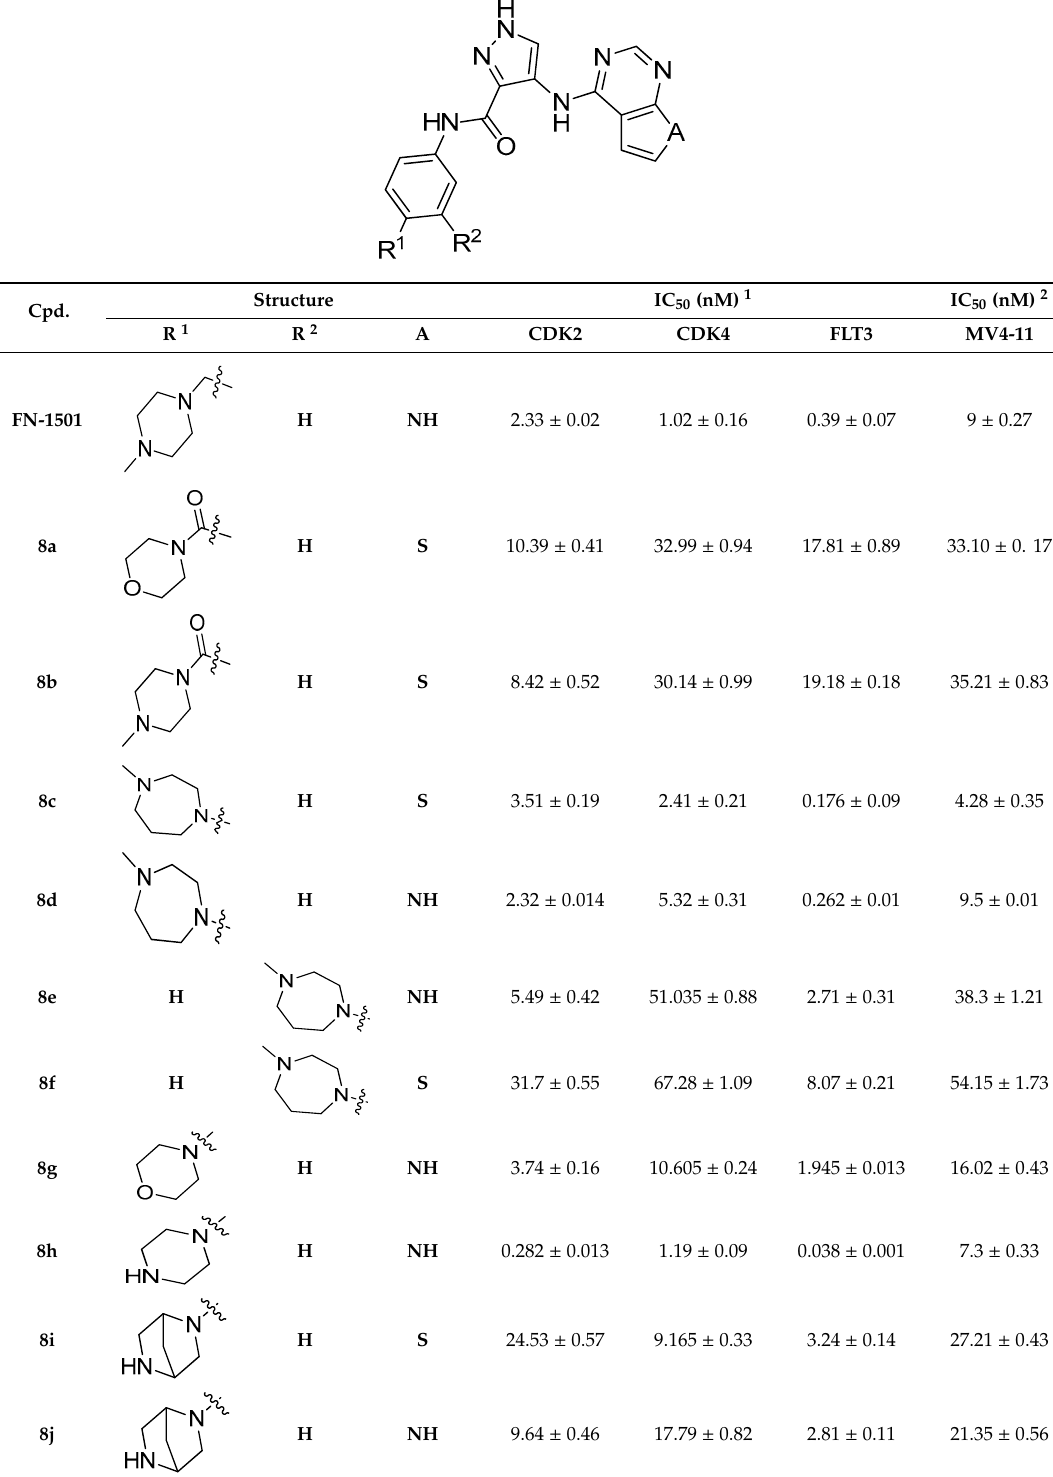
Table 3. Structures and biological activities of compounds 8a – 8j.